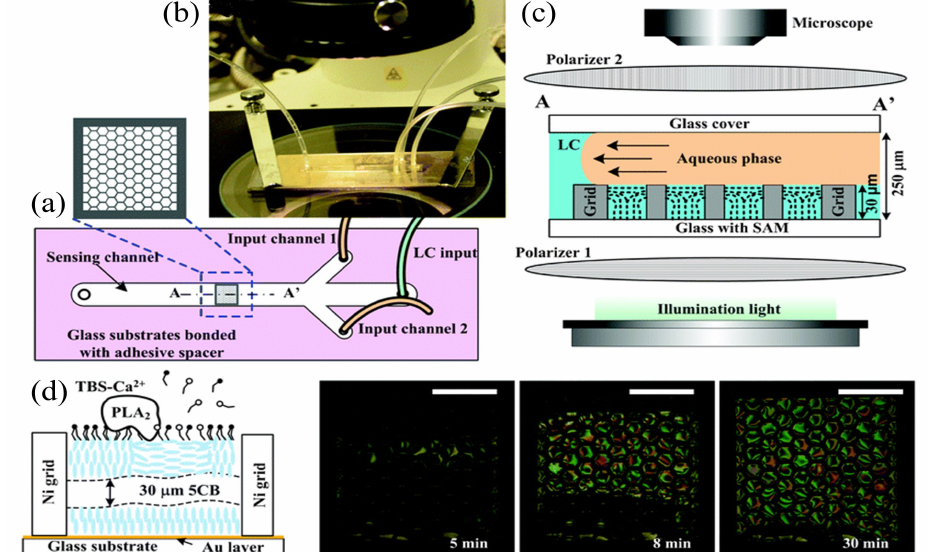
Figure 5. Setup of LC microfluidic biosensing system. ( a ) Top view diagram of the system, with hexagonal squares supporting the grid structure. ( b ) Physical picture of the system. ( c ) System was situated between two crossed polarizers with the shear force of the water to form the LC–aqueous interface. ( d ) The SAM was hydrolyzed in the presence of Ca 2 + , and the 5CB film in the central grid of the sensing channel was observed with transition (from dark to bright) in the optical image [102]; reproduced with permission from Royal Society of